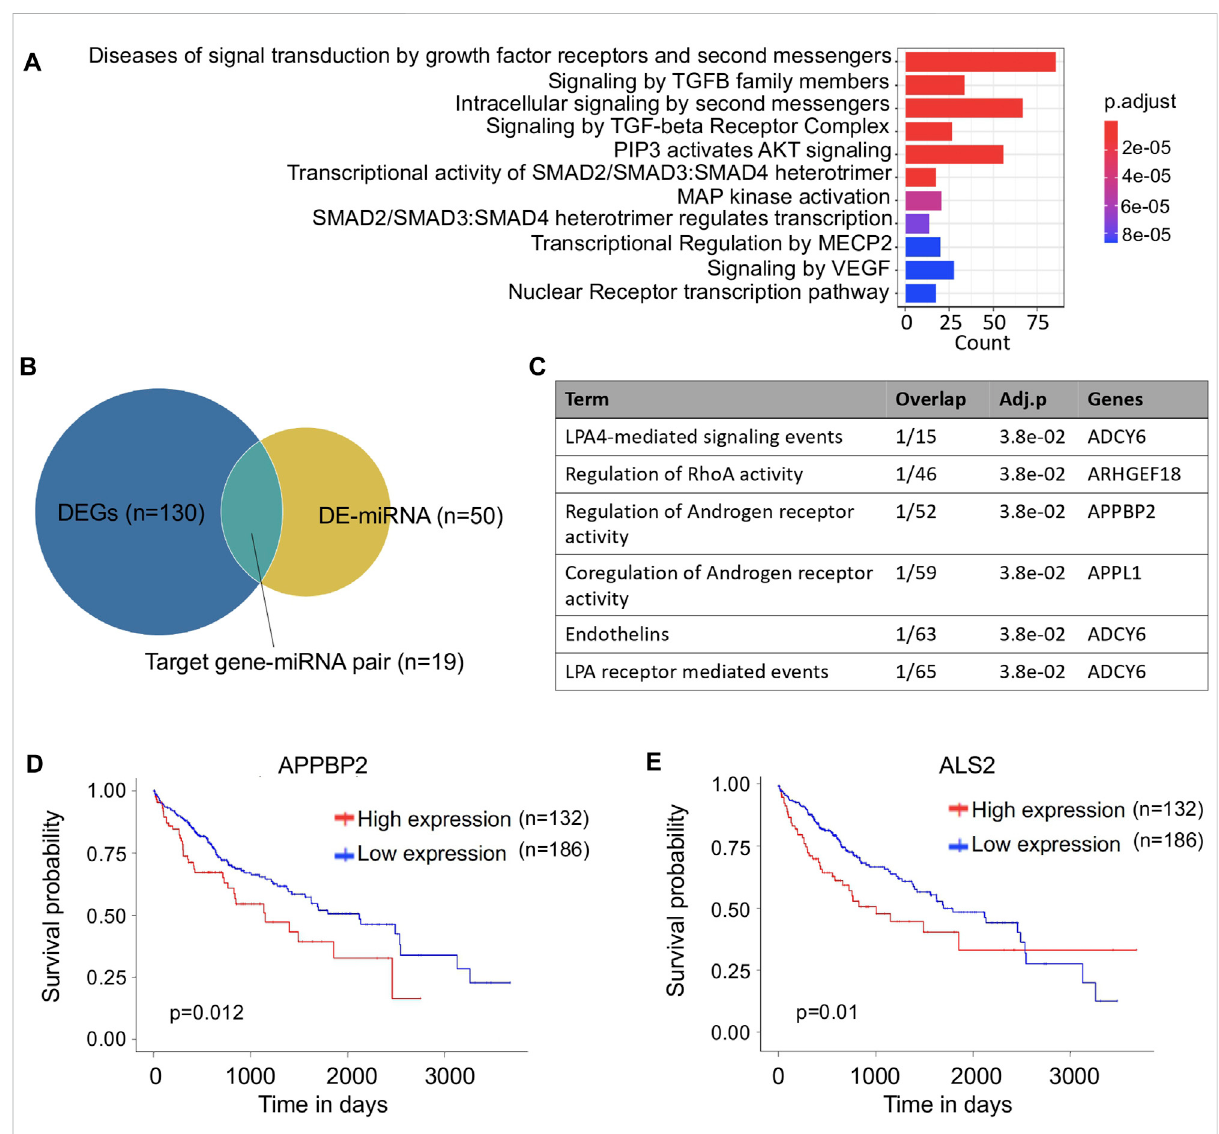
FIGURE 4 Analysis of miRNA between variant and non-variant HCCs. (A) Bar plot of enriched pathways of differentially expressed miRNA target genes. (B) Venn plot of differentially expressed mRNAs and miRNAs. (C) Functionally enriched biological processes of the miRNA target genes. (D,E) Kaplan – Meier survival curves of APPBP2 (D) and ALS2 (E) for overall survival of HCC